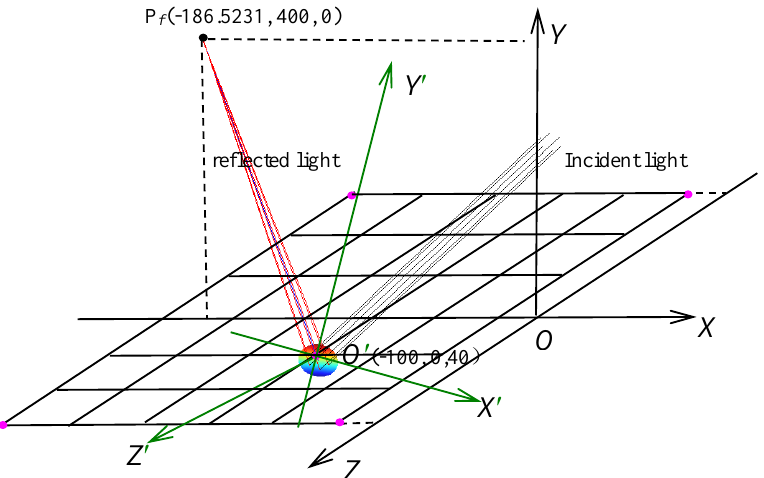
Figure 6. The focused result of a designed aspheric reflector whose vertex is not origin O of the XYZ system (in units of cm).